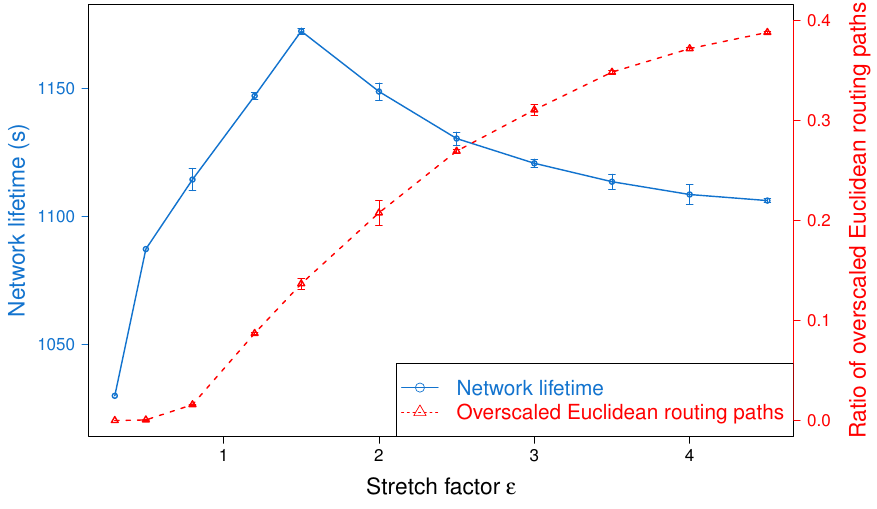
Figure 12. Impact of (cid:101) on the network lifetime. The blue lines represent the network lifetime, the red lines represent the percentage of Euclidean routing paths that exceed the network